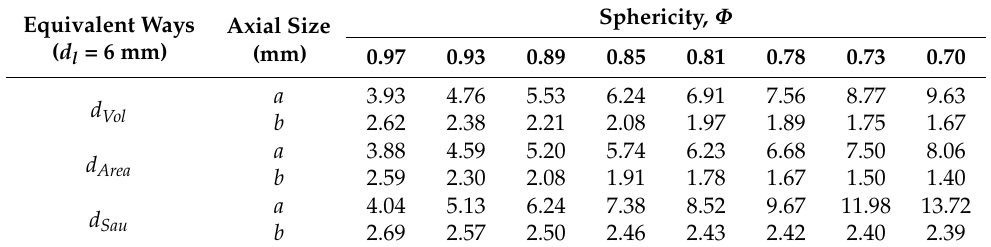
Table 3. Axial sizes of non-spherical intruders used in